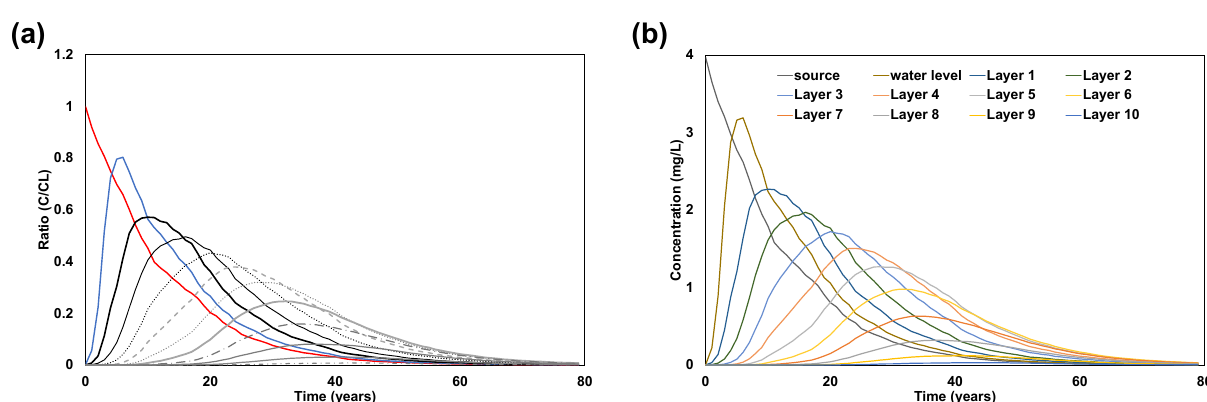
Figure 9. Temporal profile of source depletion, BTC at groundwater level and exposure concentration (L = 1 m, D = 5 m) expressed in ( a ) relative concentration compared to leaching concentration from source and ( b ) concentration for 1 mg/kg of initial source mass considered.